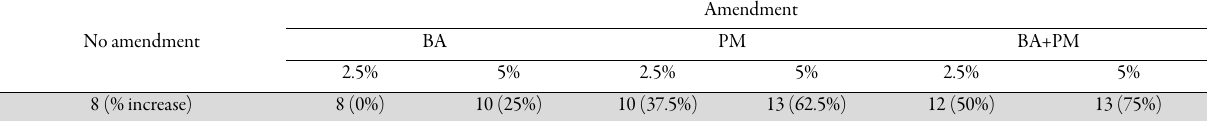
Table 7a. Effect of seed inoculation of cucumber with P. indica and soil amendment with organic wastes on disease severity of FW in the greenhouse in autoclaved soil Inoculation